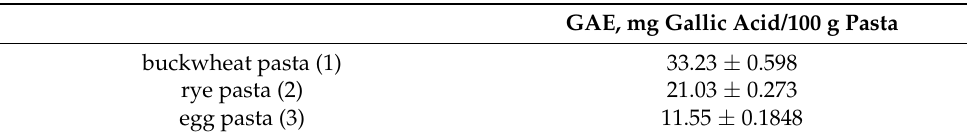
Table 3. Total phenolic content (GAE, mg gallic acid/100g, Folin–Ciocalteu method) in cooked pasta samples. Data are the mean of three determinations (standard deviation < 5%).